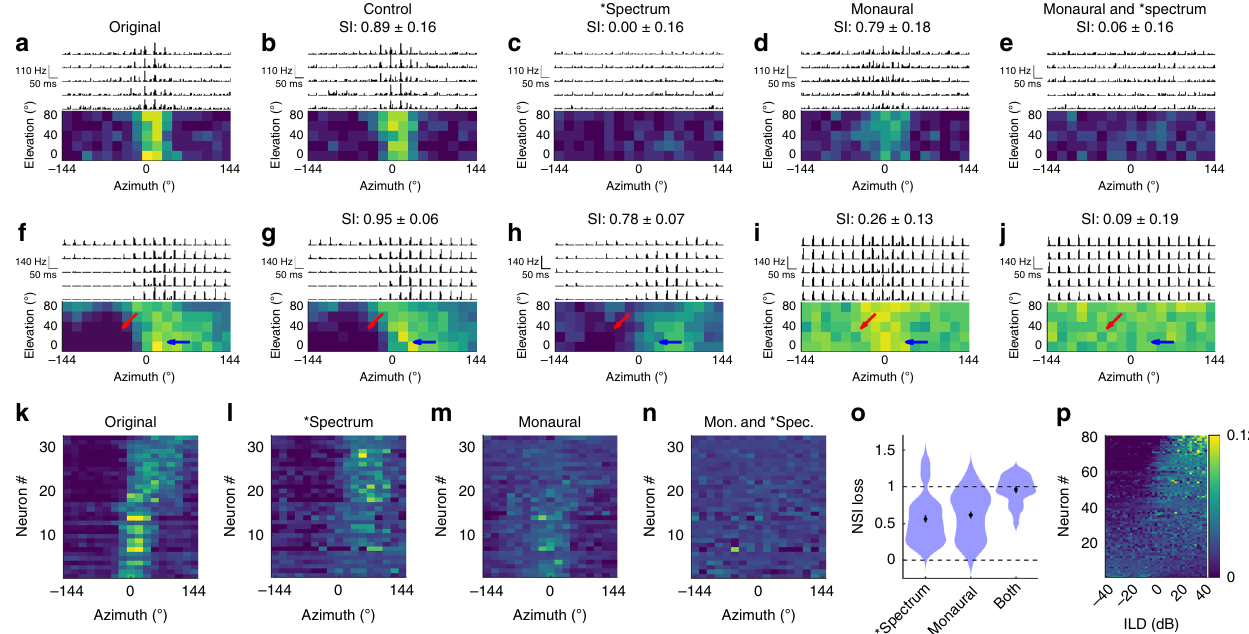
Fig. 4 Structural changes of auditory RFs due to spectrum freezing and monaural stimuli. a – e Response properties and RFs of a neuron in response to a binaural original and b control stimuli, c binaural stimuli with spectrum freezing, d monaural stimuli, and e monaural stimuli with spectrum freezing. This neuron loses its RF with spectrum freezing ( c , e ), but not with monaural stimuli ( d ). f – j An example of a neuron whose RF is comprised of spectral-cue and ILD components. Notice how the lateral part of the RF remains intact during spectrum freezing, suggesting that this part is based on ILDs. The frontal part of the RF remains intact with monaural stimuli, suggesting that this part is based on monaural spectral cues. With the monaural stimulus, the ipsilateral side has responses (red arrow) that are not seen in binaural stimuli ( f – h ). k – n Horizontal RFs of 32 neurons. For each neuron, the scale of the responses is normalized by dividing by the sum across all directions. The range of the color scale is from 0 to 0.3. Spectrum freezing results in distorting the frontal RFs and maintaining the lateral RFs ( l ). Monaural stimuli result in maintaining the frontal RFs, distorting the lateral RFs and reducing the suppression of the ipsilateral RFs ( m ). When both are implemented, all the RFs disappear ( n ). o Summary of the NSI loss to spectrum freezing, monaural stimulation, and both. Spectrum freezing and monaural stimuli have a similar level of NSI loss, but their roles are different. When both are implemented, the NSI is close to 1, meaning that the RFs are completely lost. Source data are provided as a Source Data fi le. p Responses of the ILD-sensitive SC neurons to an extended range of ILDs. The fi ring rates (FRs) are normalized by the sum across the full ILD range for each neuron. Neurons with non- fl at responses to ILDs (a fl at distribution fi t gives a large χ 2 value ( p < 0.01)) are shown. For most neurons, the FR changes monotonically as a function of the ILD, and is not “ tuned ” to a speci fi c ILD